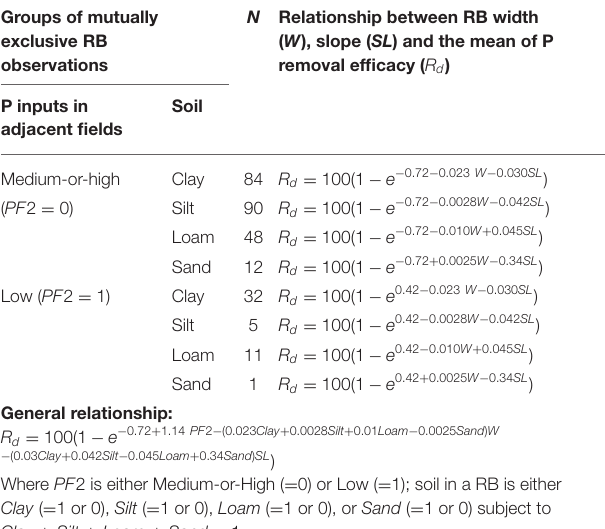
TABLE 5 | Functional forms of the best regression model that explain the relationship of P retention effectiveness ( R d ), slope, and width of riparian buffers. N Relationship between RB width Groups of mutually ( W ), slope ( SL ) and the mean of P exclusive RB removal efficacy ( R d observations